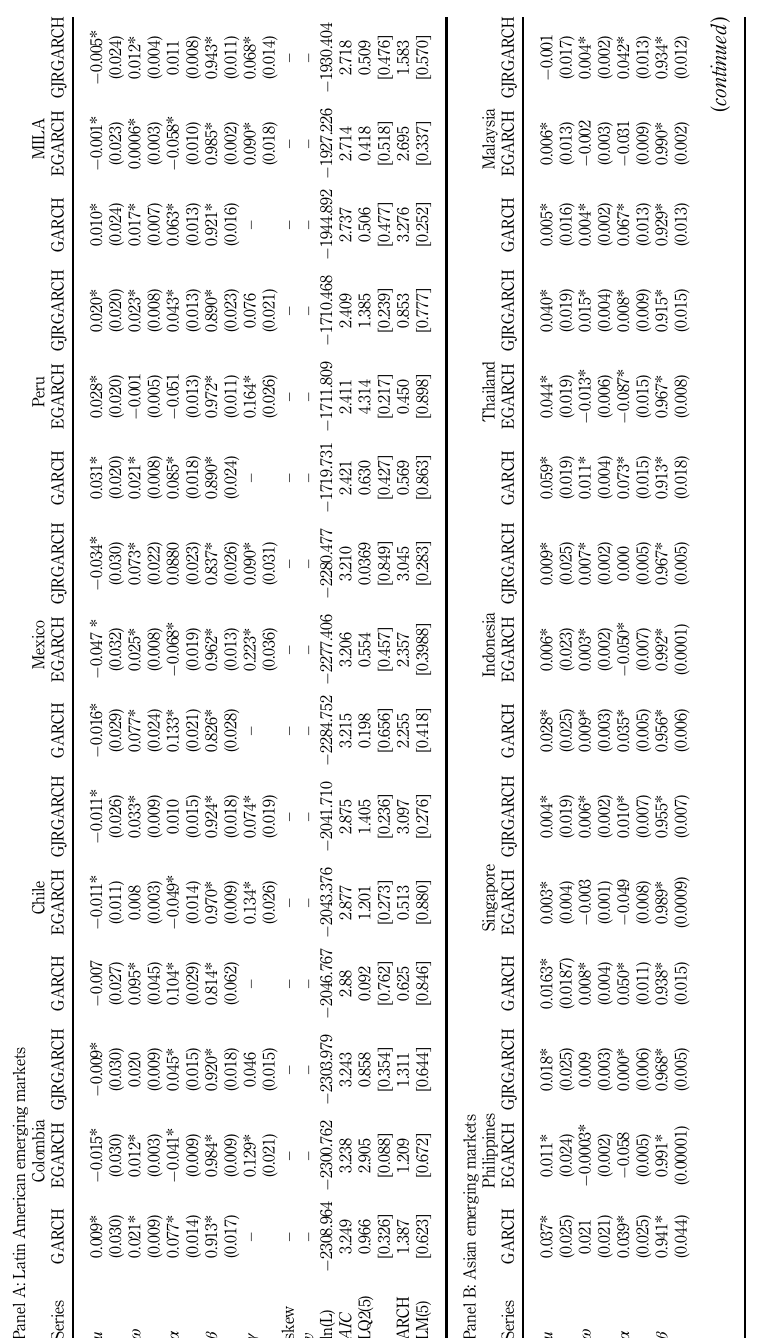
Table 2. Estimation results